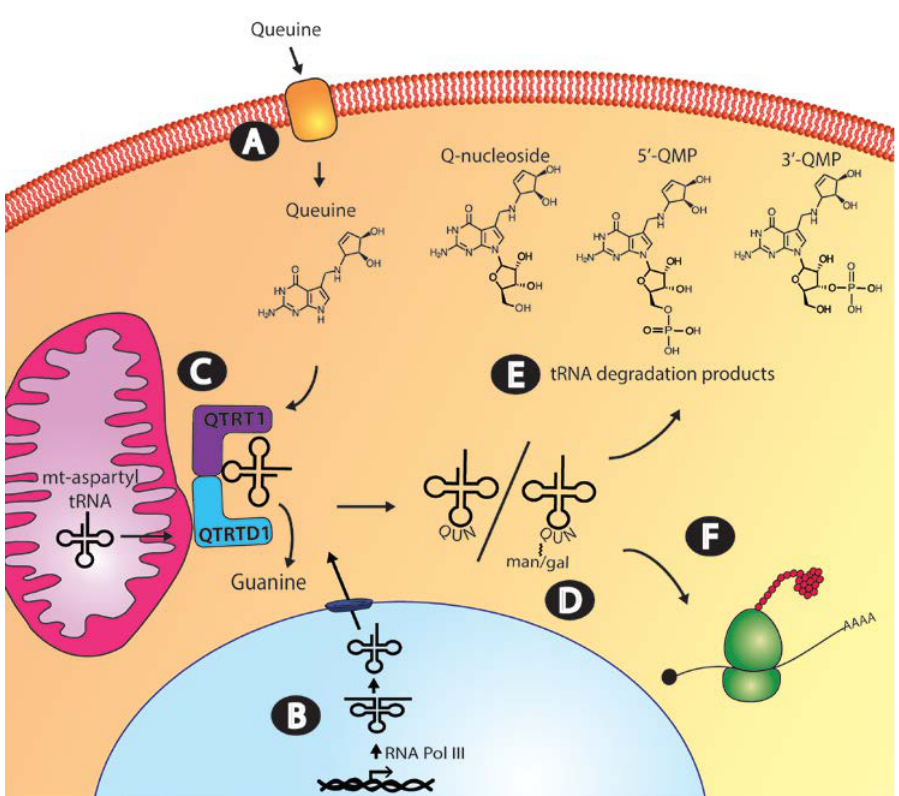
Figure 3. Queuine uptake, incorporation and salvage in the eukaryotic cell. ( A ) Transport of queuine into the cell occurs through a rapidly saturating low K m component and a slower-uptake high K m component; ( B ) the queuine-insertase enzyme modifies both cytosol and mitochondrial tRNA. Cytosolic tRNA is transcribed in the nucleus by RNA polymerase III, whereas mitochondrial tRNA is transcribed in the mitochondria by mitochondrial-directed RNA polymerase, before processing to the mature tRNA molecule; ( C ) Queuine tRNA-ribosyltransferase 1 (QTRT1) and queuine-tRNA ribosyltransferase domain containing 1 (QTRTD1) subunits of the queuine-insertase complex are cytosolic proteins that appear to co-localize to the mitochondrial membrane where queuine base is incorporated into cytosolic tyrosyl, asparaginyl, aspartyl and histidyl tRNA and mitochondrial aspartyl tRNA. ( D ) Cytosolic aspartyl and tyrosyl Q-modified tRNA can be further modified by the addition of mannose and galactose sugars, respectively. ( E ) Salvage of the queuine base from tRNA turnover could occur from queuosine nucleoside, queuosine-5′-monophosphate (5 ′ -QMP) or queuosine-3′-monophosphate (3 ′ -QMP). Correct functioning of uptake, incorporation and salvage of queuine base is essential to maintaining appropriate cellular Q-modified tRNA levels. ( F ) tRNA GUN recognize the dual synonymous codons ending in either a C or U which pairs to the wobble